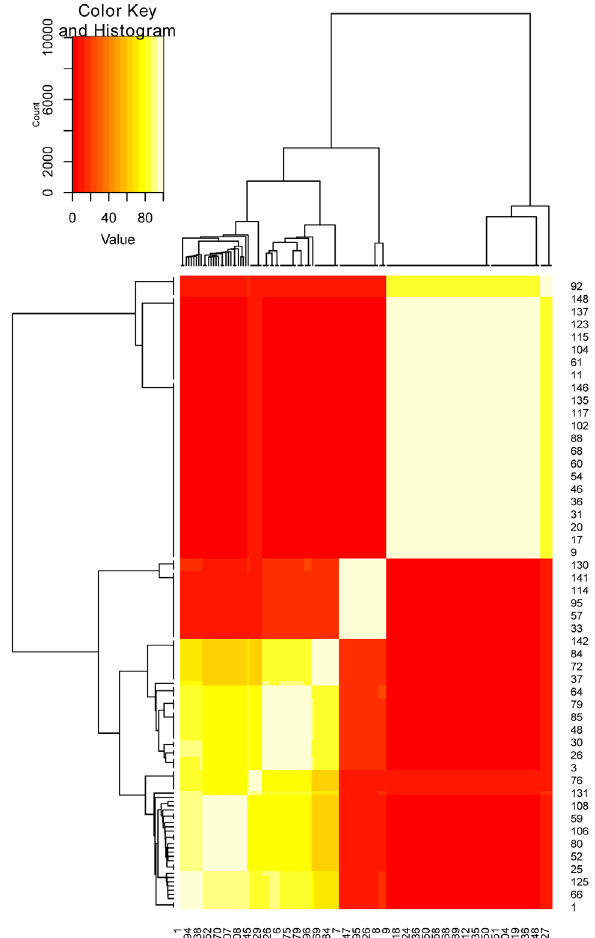
FIGURE 4 | Analysis of the FASTBAPS program. Numbers are individual sequence of Brachyplatystoma vaillantii . Colors ranging from red for the lowest probabilities and clear yellow for the highest probabilities support for